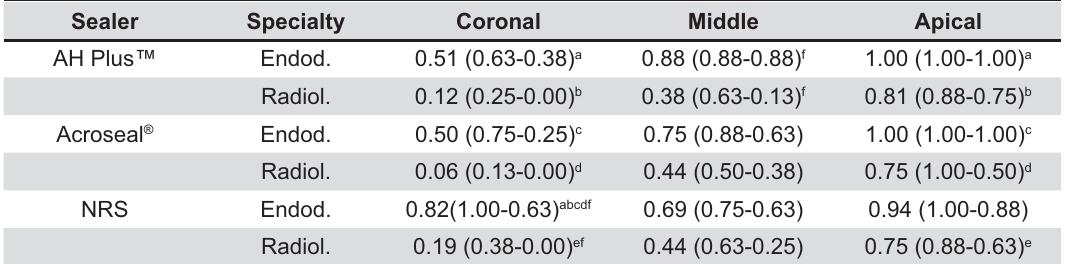
Table 1- (cid:2)"(cid:4)(cid:10)(cid:8)(cid:2)(cid:12)(cid:10)(cid:20)(cid:30)(cid:4)(cid:7)(cid:2)(cid:10)(cid:8)(cid:13)(cid:2)(cid:6)(cid:10)(cid:8)(cid:15)(cid:4)(cid:7)(cid:2)(cid:14)(cid:19)(cid:2)(cid:7)(cid:4)(cid:8)(cid:7)(cid:11)(cid:9)(cid:11)(cid:12)(cid:11)(cid:9)(cid:23)(cid:2)(cid:11)(cid:8)(cid:2)(cid:4)(cid:10)(cid:17)(cid:16)(cid:2)(cid:9)(cid:16)(cid:11)(cid:6)(cid:13)(cid:2)(cid:14)(cid:19)(cid:2)(cid:9)(cid:16)(cid:4)(cid:2)(cid:21)(cid:20)(cid:20)(cid:11)(cid:8)(cid:15)(cid:7)(cid:2)(cid:10)(cid:7)(cid:7)(cid:4)(cid:7)(cid:7)(cid:4)(cid:13)(cid:2)(cid:22)(cid:23)(cid:2)(cid:9)(cid:16)(cid:4)(cid:2)(cid:4)(cid:24)(cid:10)(cid:18)(cid:11)(cid:8)(cid:4)(cid:6)(cid:7)(cid:2)(cid:25)(cid:7)(cid:10)(cid:18)(cid:4)(cid:2)(cid:20)(cid:4)(cid:9)(cid:9)(cid:4)(cid:6)(cid:7)(cid:2)(cid:11)(cid:8)(cid:13)(cid:11)(cid:17)(cid:10)(cid:9)(cid:4)(cid:2) (cid:7)(cid:9)(cid:10)(cid:9)(cid:11)(cid:7)(cid:9)(cid:11)(cid:17)(cid:10)(cid:20)(cid:20)(cid:23)(cid:2)(cid:7)(cid:11)(cid:15)(cid:8)(cid:11)(cid:21)(cid:17)(cid:10)(cid:8)(cid:9)(cid:2)(cid:13)(cid:11)(cid:19)(cid:19)(cid:4)(cid:6)(cid:4)(cid:8)(cid:17)(cid:4)(cid:2)(cid:10)(cid:9)(cid:2)#$%